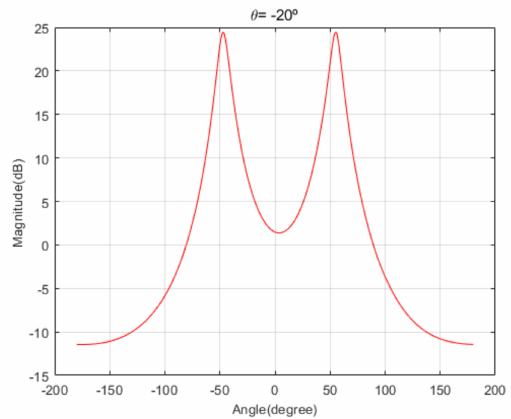
Figure 8. Spatial spectrum of CAPON for the second scenario (elevation angle = − 20 ◦ ).